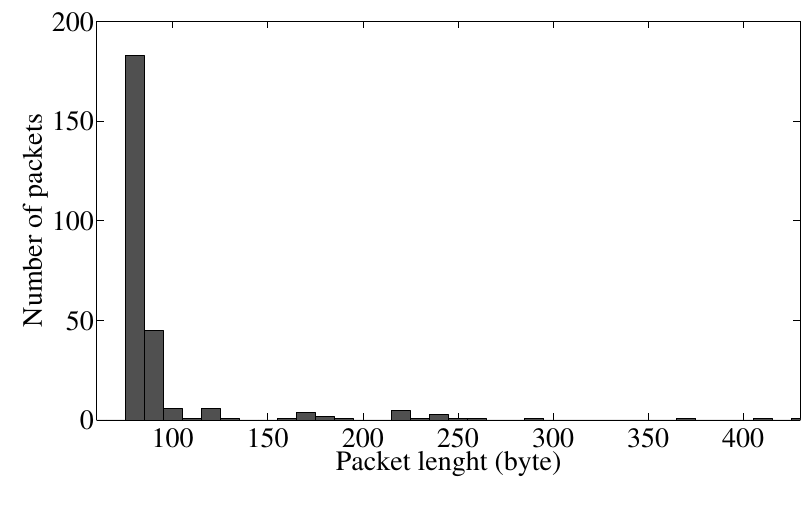
Figure 8. Histogram of the length of Facebook push